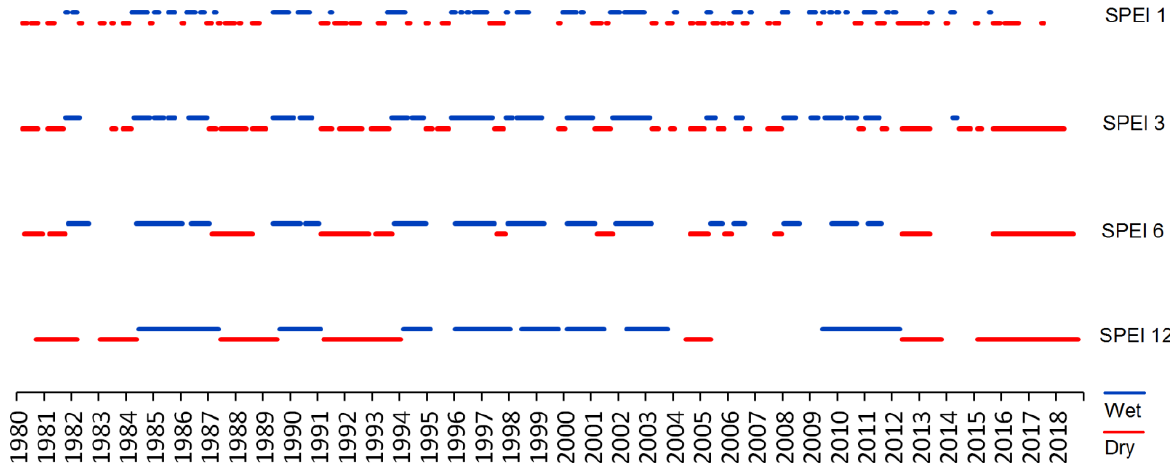
Figure 4. SPEI-1, SPEI-3, SPEI-6, and SPEI-12 dry (red) and wet (blue) events that occurred over the ESA during 1980–2018. The episodes were identified following the criteria of McKee et al. [16]. White parts of the plot mean neutral periods.